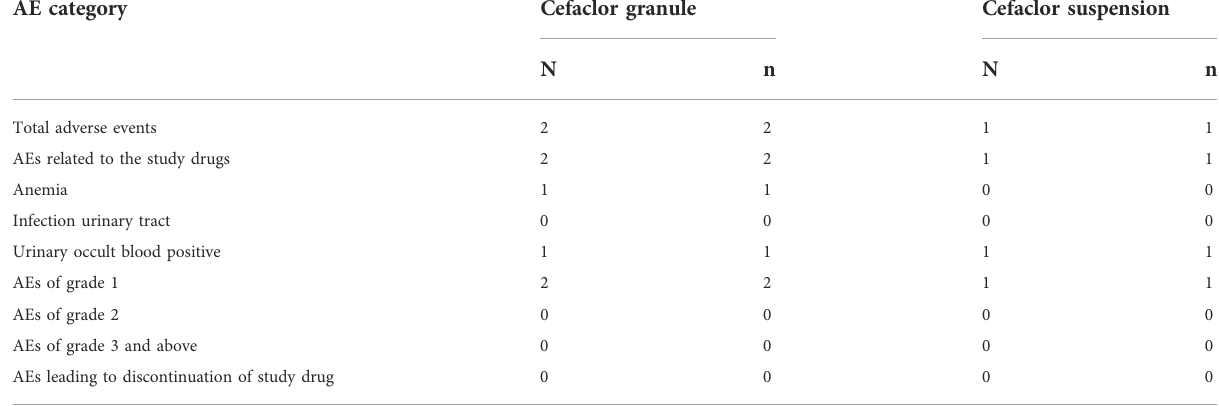
TABLE 6 Summary of AEs for Cefaclor granule and Cefaclor suspension in postprandial